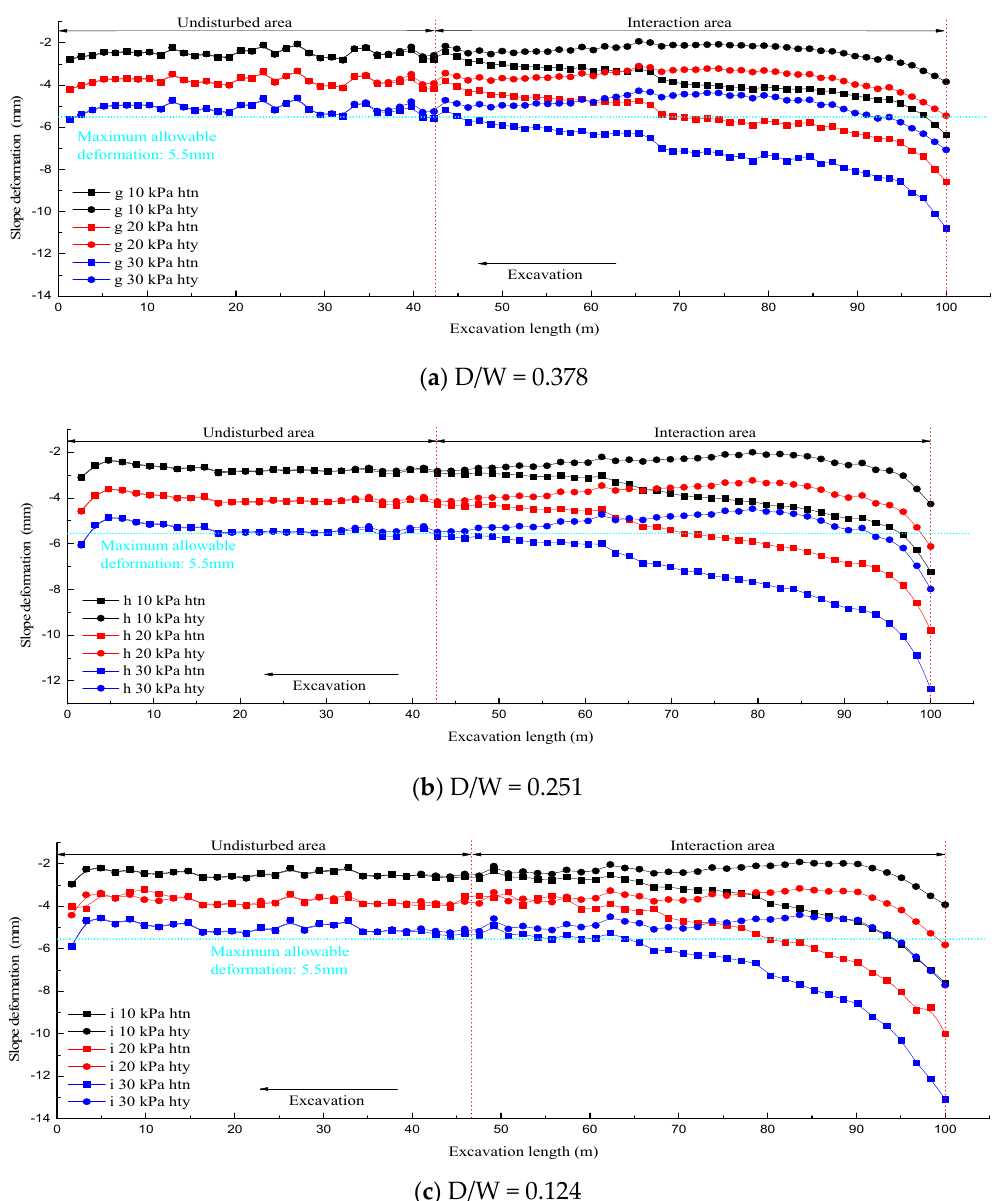
Figure 21. Longitudinal surface settlement of models D-D to F-F with C/H = 0.606.